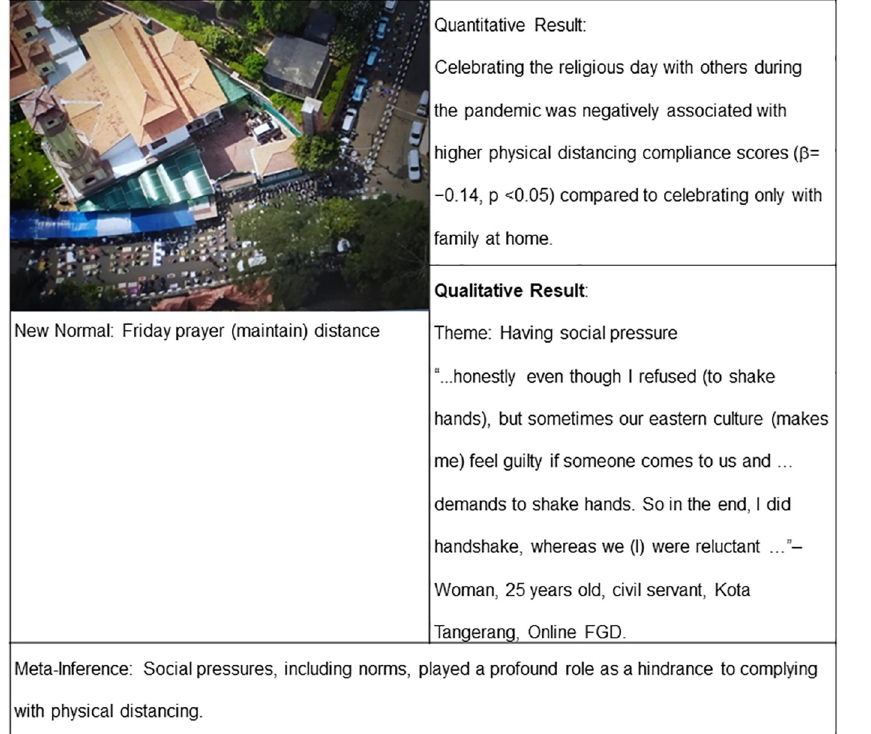
Fig 4. Joint display of clear indicators, social pressure, and physical distancing